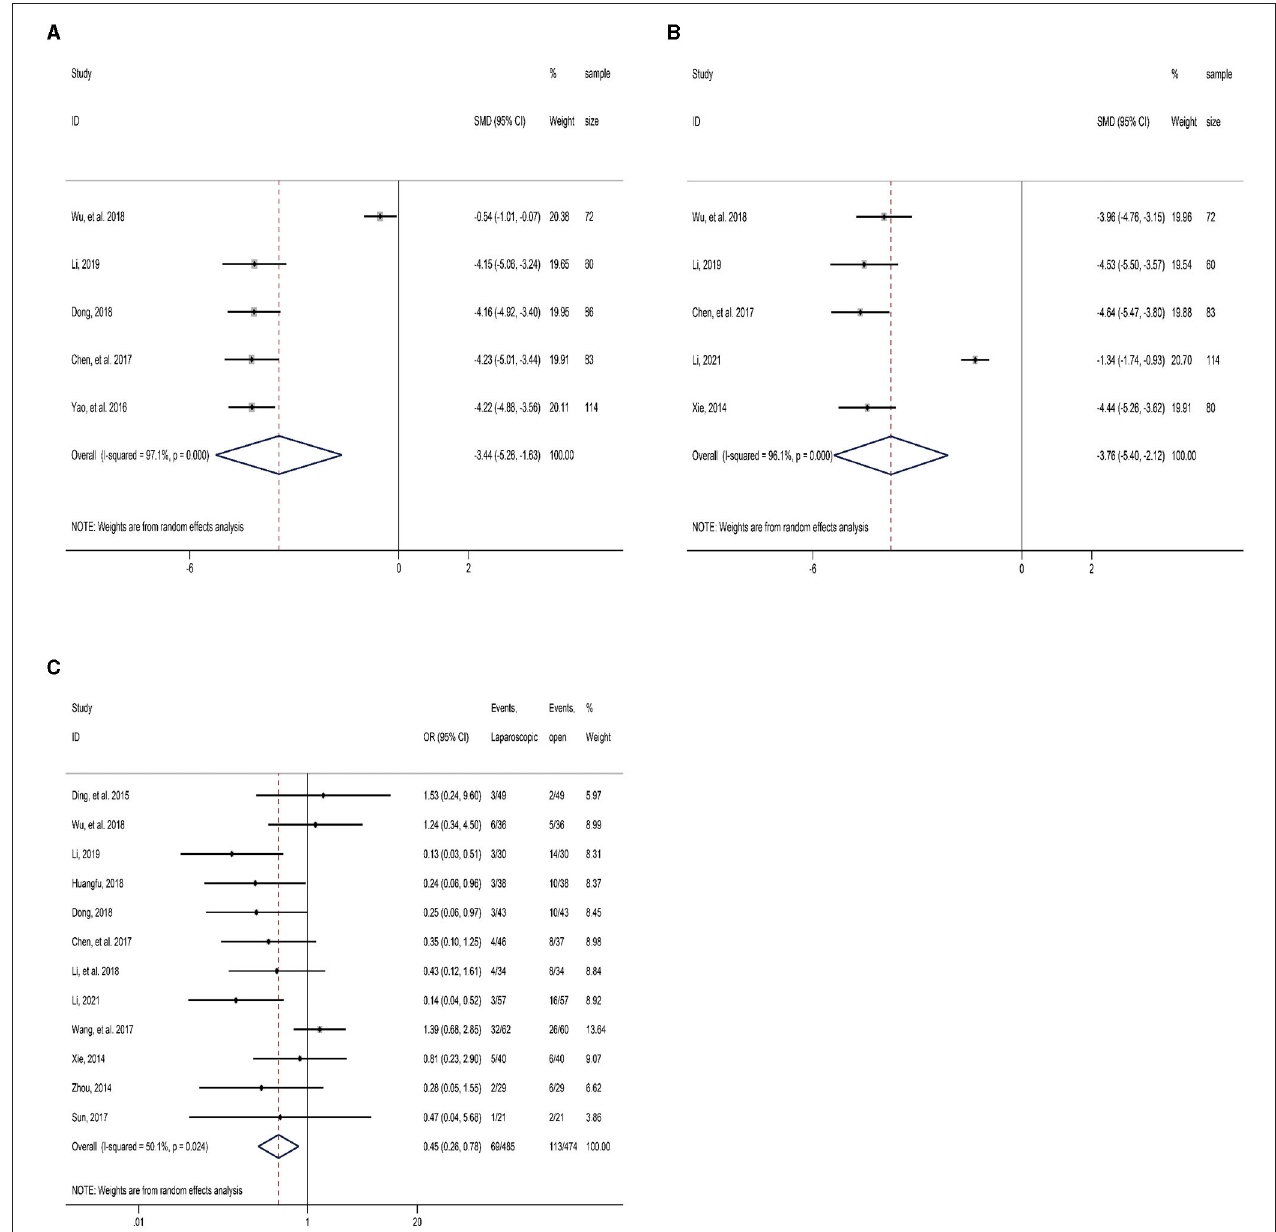
FIGURE 4 | Forest plot of comparison between LLLH and OLLH in hepatolithiasis patients. (A) time to postoperative ambulation; (B) surgical incision length; and (C) postoperative